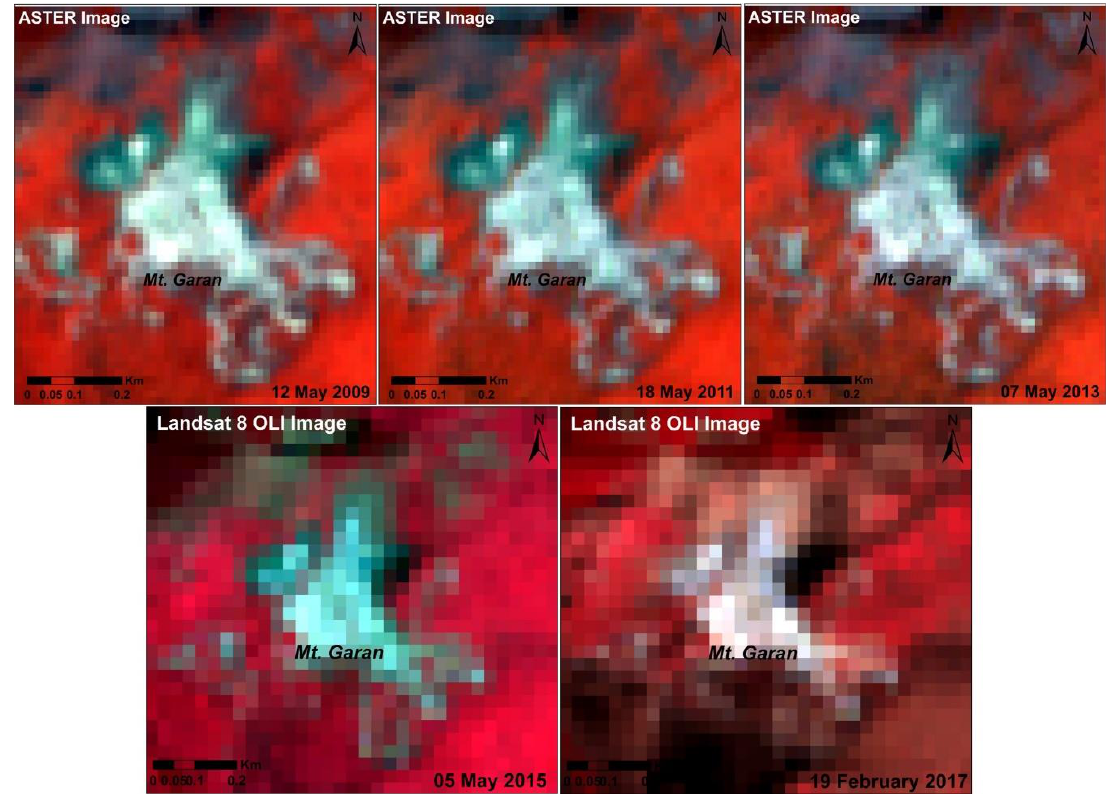
Figure 4. Top row : False color composite of red/green/blue (RGB) of NIR-visible bands of ASTER satellite images of the Mt. Garan fumarole area for 2009, 2011, and 2013. Bottom row : Band composite of RGB of NIR-visible bands of Landsat 8 OLI of the Mt. Garan fumaroles for 2015 and 2017.